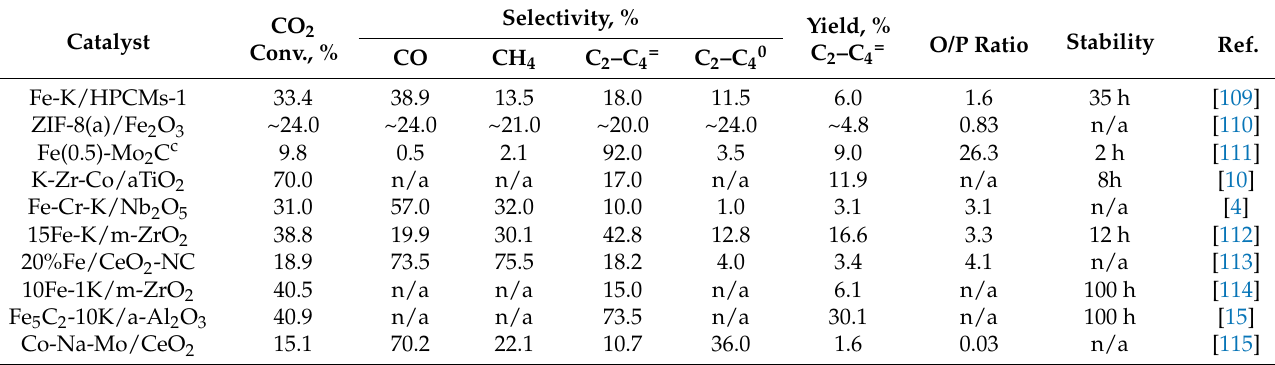
Table 2. Some representative catalysts of the support effect for CO 2 hydrogenation to light olefins. Catalyst CO 2 Conv., %